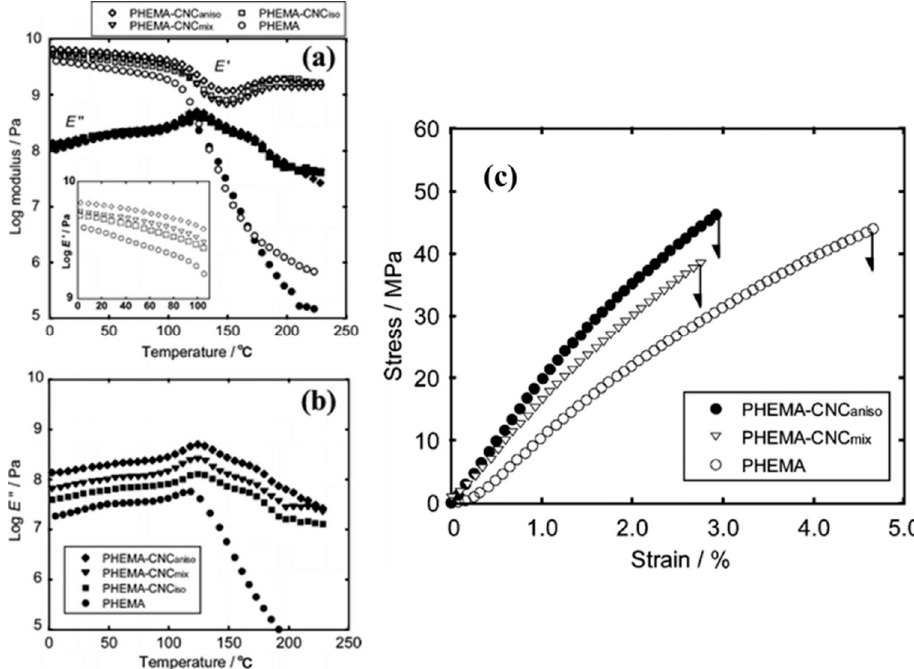
Figure 8. Temperature dependence of the storage modulus (E ′ ) and the loss modulus (E ″ ), measured for the film samples of poly (2-hydroxyethylmethacrylate) (PHEMA) and three PHEMA–cellulose nanocrystal (CNC) composites: ( a ) the plot of E ′ and E ″ as a function of temperature, and an enlarged plot of the glass-state modulus E ′ (inset). ( b ) E ″ data plotted by displacing by 0.25 log unit in the ordinate. ( c ) Examples of the stress − strain curves measured for the films of PHEMA, PHEMA − CNC aniso , and PHEMA − CNC mix . Reprinted with permission from Tatsumi et al., Biomacromolecules 2012 , 13